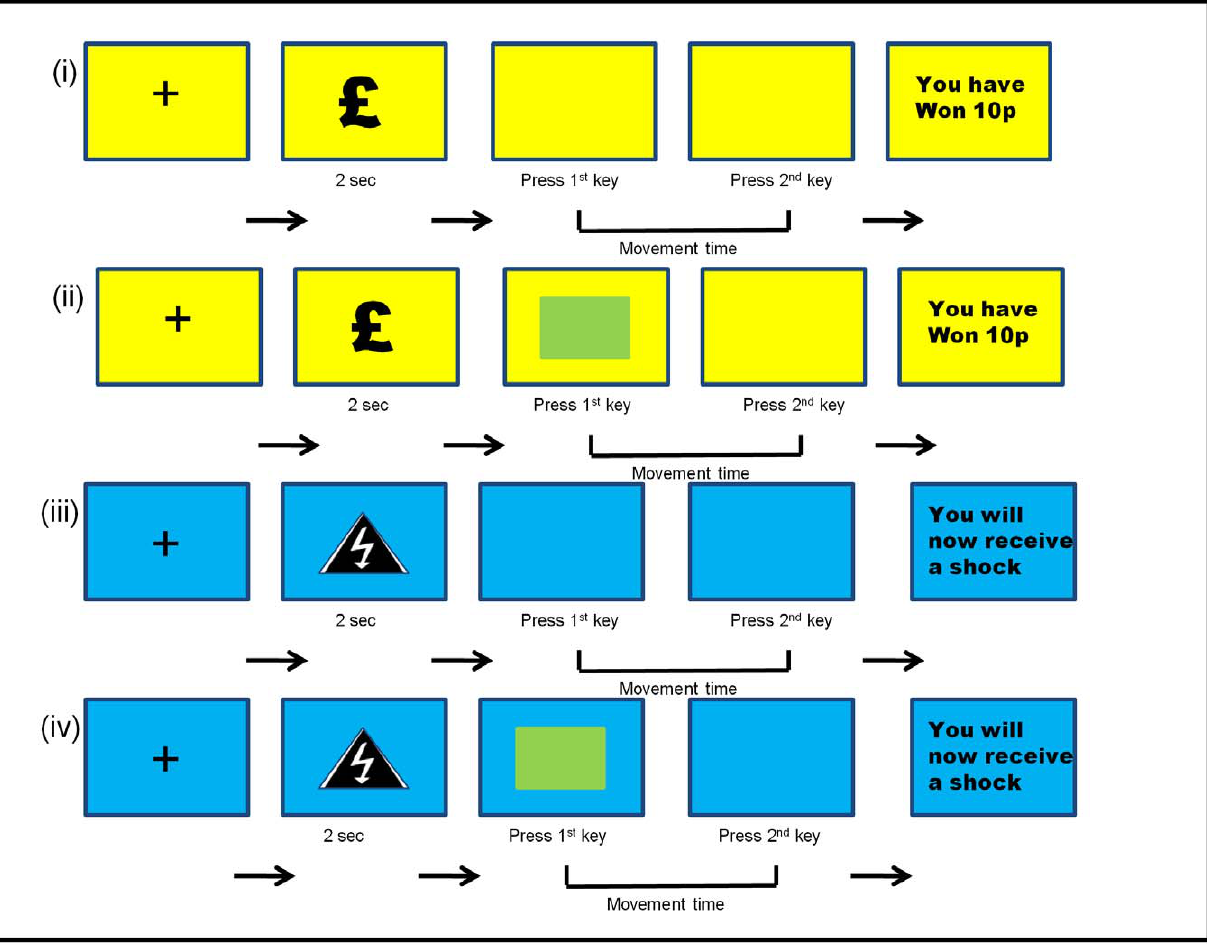
Figure 1. Schematic of the movement time task. Trial types are illustrated as a function of outcome valence (yellow for money trials and blue for shock trials) and presence or absence of a distractor (green flashing square). There were two possible outcomes in the money trials; ‘you have won 10 p’ or ‘you have not won 10 p’ and there were two possible outcomes for the shock trials; ‘you will now receive a shock’ or ‘you will now not receive a shock’. Subjects were exposed to 4 distinct trial types (see methods for details) comprising (i) money trial without distractor, (ii) money trial with distractor, (iii) shock trial without distractor, (iv) shock trial with distractor.